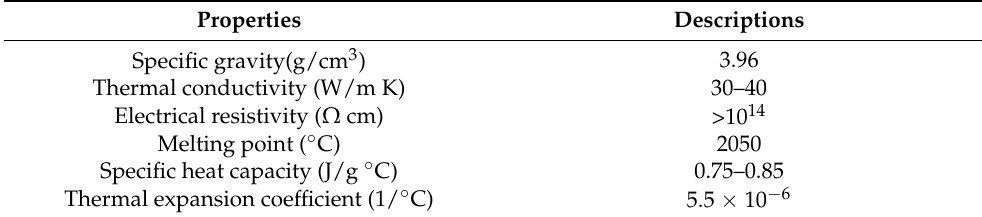
Table 1. Material properties of the Al 2 O 3 .